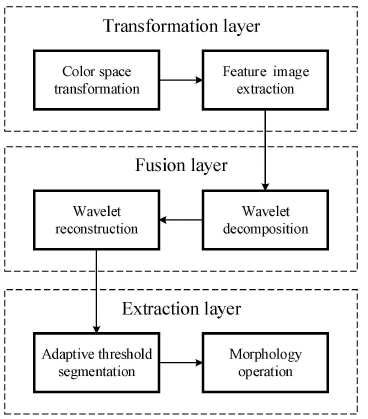
Figure 2. Overview of the automated tomato recognition